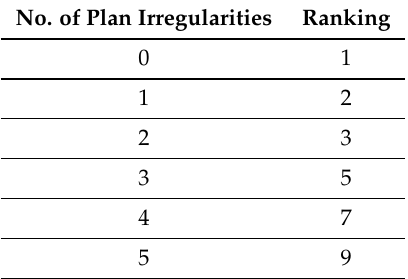
Table 6. ‘Plan irregularity’ rankings considered in MCDM methods.